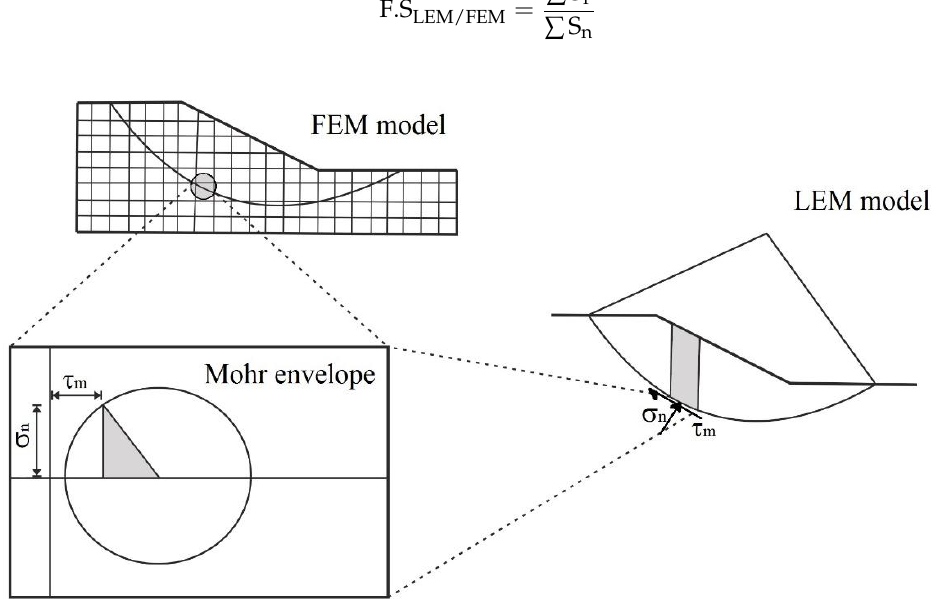
Figure 2. The stability analysis based on LEM/FEM [33].